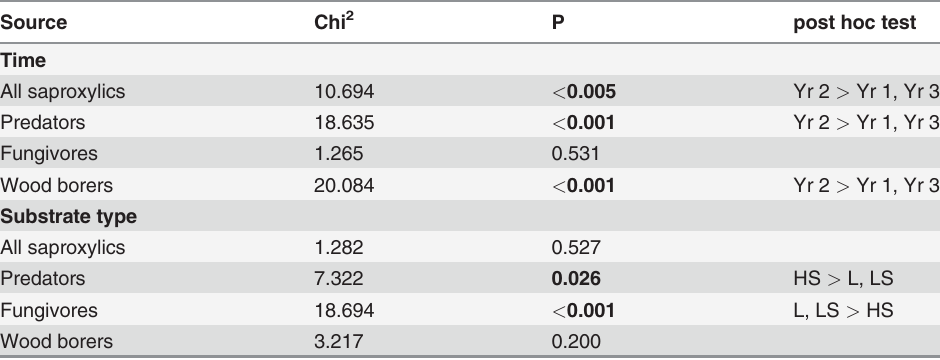
Wood borers 3.217